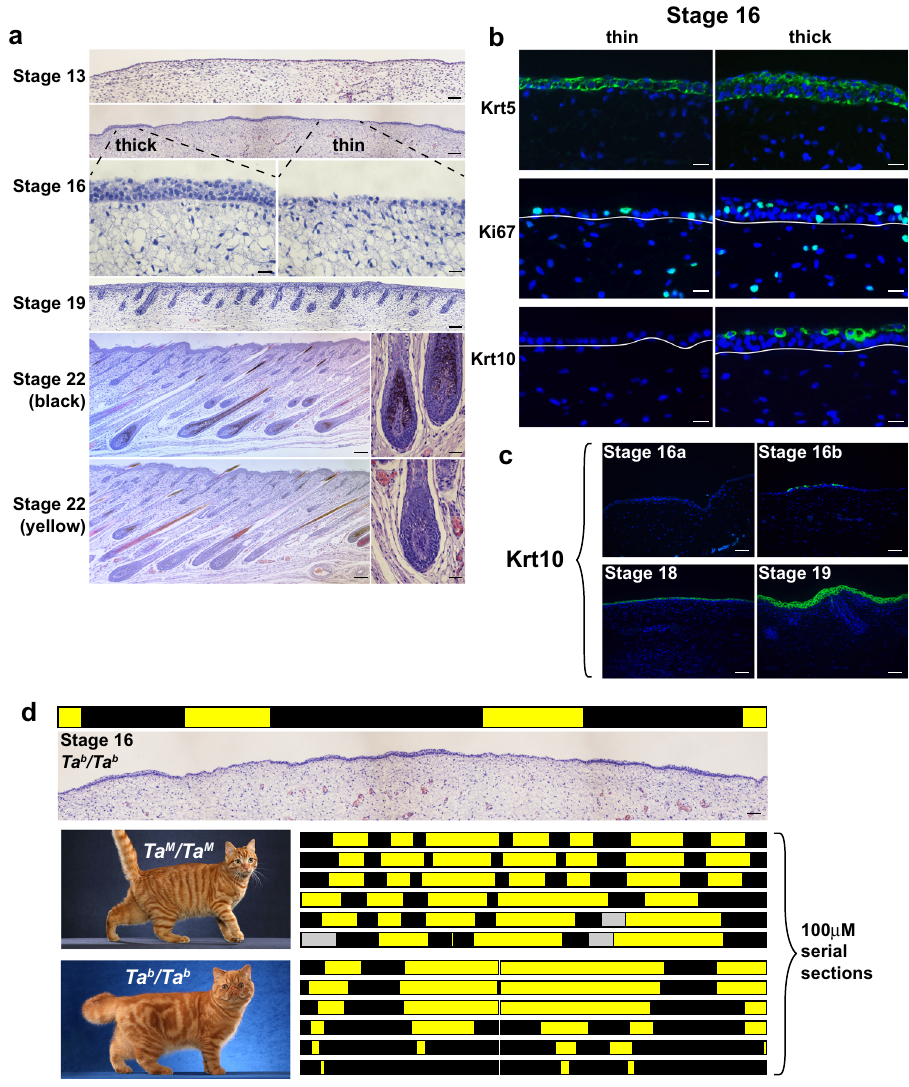
Fig. 1 Patterns of epidermal thickening in fetal cat skin. a Cat skin histology at different developmental stages (stage 16, bottom panels — high power fi elds of the thick and thin epidermis; stage 22, right panels — high power fi elds of black and yellow follicles). b Immuno fl uorescence for Krt5, Ki67, and Krt10 (green) in stage 16 skin sections (DAPI, blue; white lines mark dermal-epidermal junction). c Krt10 immuno fl uorescence (green) on cat skin at different developmental stages (DAPI, blue). All micrographs ( a ) and immuno fl uorescence ( b , c ) observations were made independently on three or more embryos with similar results. d Topological maps based on skin histology (thin, yellow; thick, black) from Ta M /Ta M and Ta b /Ta b stage 16 embryos mimic pigmentation patterns observed in adult animals (left panels; gray bar — no data). Maps were developed independently on three embryos of each genotype with similar results. Representative images of adult color pattern in Ta M /Ta M and Ta b /Ta b animals (from Helmi Flick, with permission) are shown on the left. Scale bars: a stage 13, 50 μ M; stage 16 (top), Stage 19, stage 22 (left) 100 μ M; stage 16 (bottom), stage 22 (right) 25 μ M; b 25 μ M; c , d 50 μ